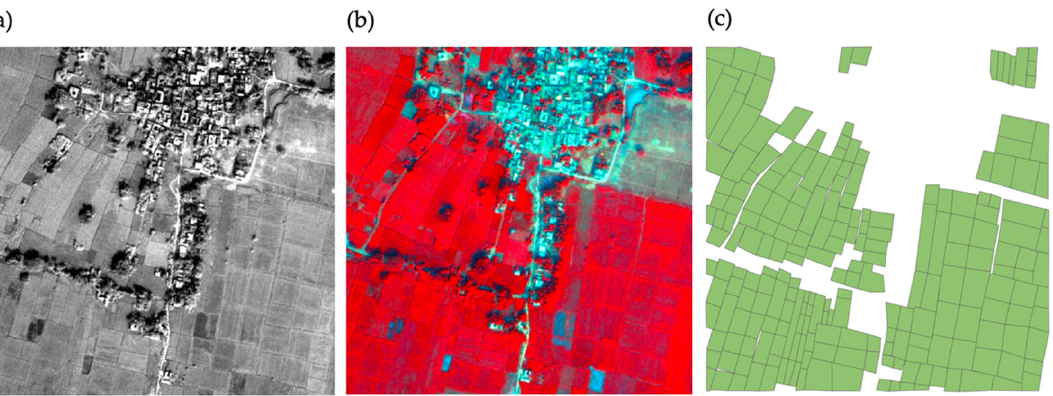
Figure 3. ( a ) Example of panchromatic imagery, ( b ) multispectral imagery, and ( c ) digitized field polygons for one 1024 × 1024 pixel tile. polygons for one 1024 × 1024 pixel